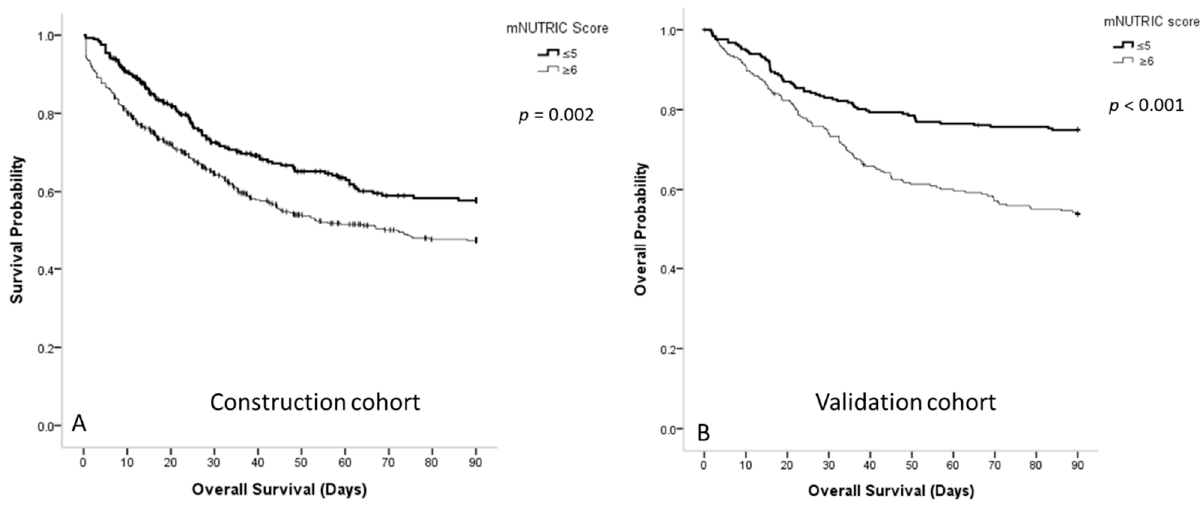
Figure 1. ( A ) Survival curve for the patients with sepsis in the medical intensive care unit according to the mNUTRIC scores in the construction cohort; ( B ) survival curve for the patients with sepsis in the medical intensive care unit according to the mNUTRIC scores in the validation cohort.